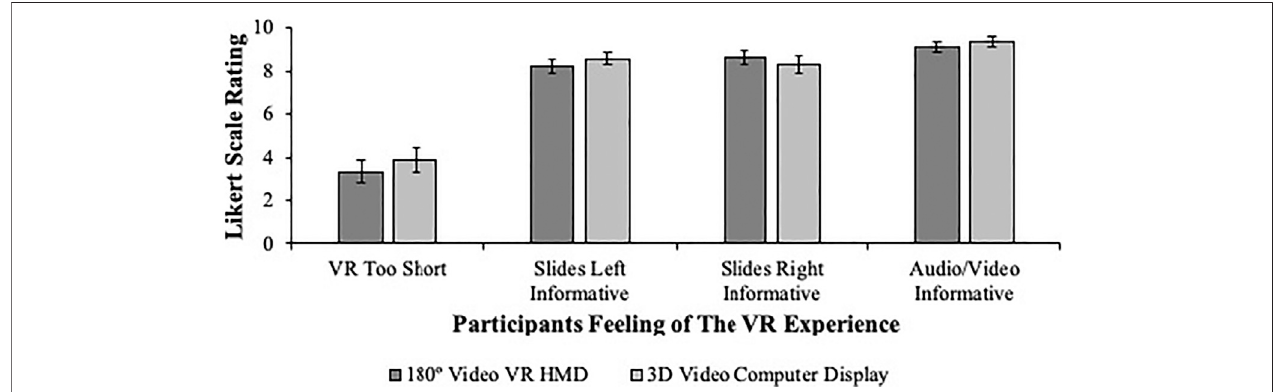
FIGURE3| Between-groupsparticipants ’ feelingsabouttheVRexperience.Regardlessofthegroup(darkgraybars (cid:1) 180 ° videoVRHMDandlightgraybars (cid:1) 3D video computer display), the participants felt similarly that the VR experience was not too short and that the slides to the left and the right and the audio/video that was providedwereinformative.Thus,theparticipantsfoundthepresentationoftheVRexperienceinboththe180 ° videoVRHMDandthe3Dvideocomputerdisplayformats to be educationally informative. The data are illustrated as the mean ±